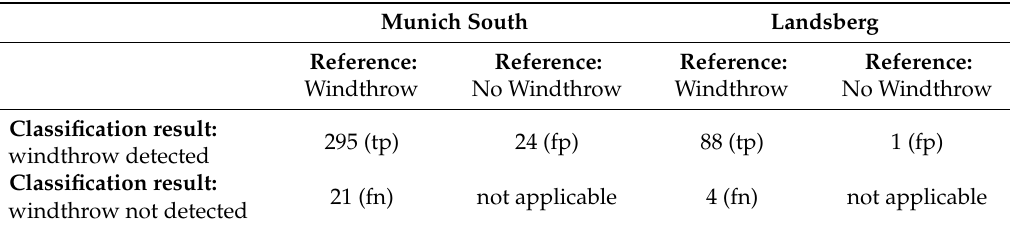
Table 9. Contingency table of binary classifier for Munich South and Landsberg . Munich